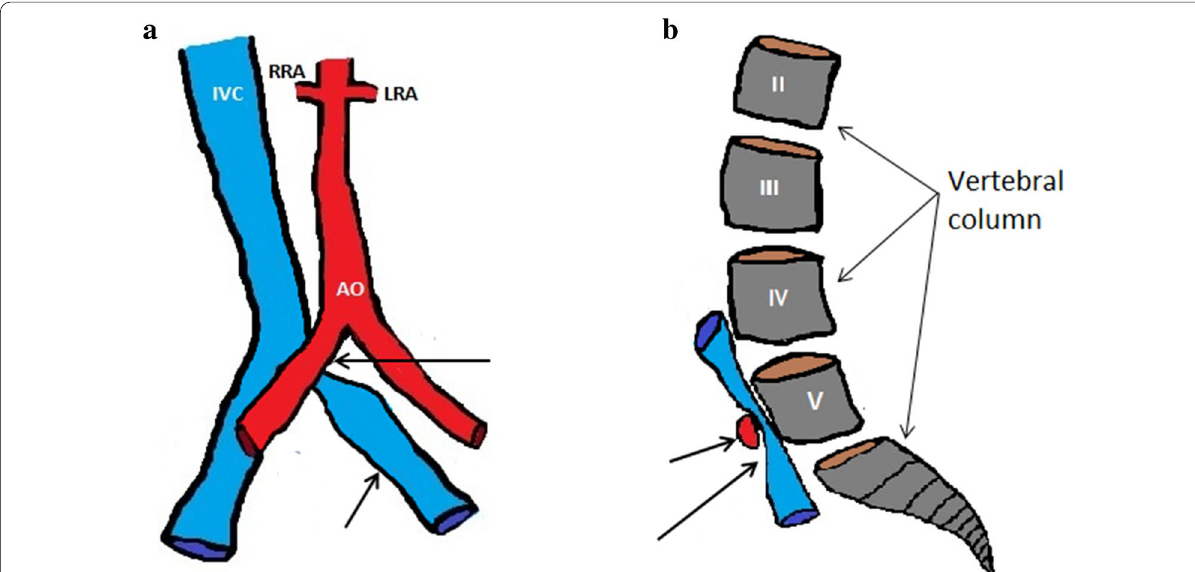
Fig. 11 MTS. Scheme summarizing describing the main anatomical structures involved in the syndrome. a Left common iliac vein compression (short arrow) by the right common iliac artery (long arrow). AO Abdominal aorta. IV c Inferior cava vein. RR a Right renal artery. LRA Left renal artery. b This illustration shows the right common short iliac artery which compresses the left common iliac vein (long arrow) against the spinal